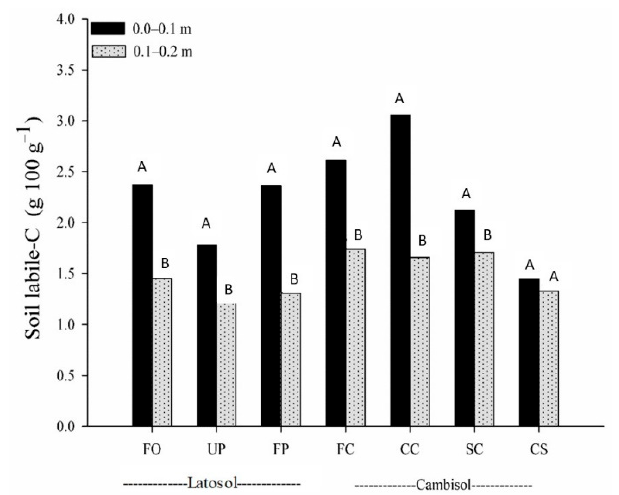
Figure 3. Soil labile-C (g kg − 1 ) for latosol (forest-FO, unfertilized pasture-UP, fertilized pasture-FP) and cambisol (f-FC, pasture, coast cross-CC, sugarcane-SC and corn silage-CS) for the surface (0.0–0.1) and subsurface (0.1–0.2 m) layers. Within each soil type/land use combination, bars with different upper-case letters are significantly different ( p < 0.05) between surface and subsurface layers.